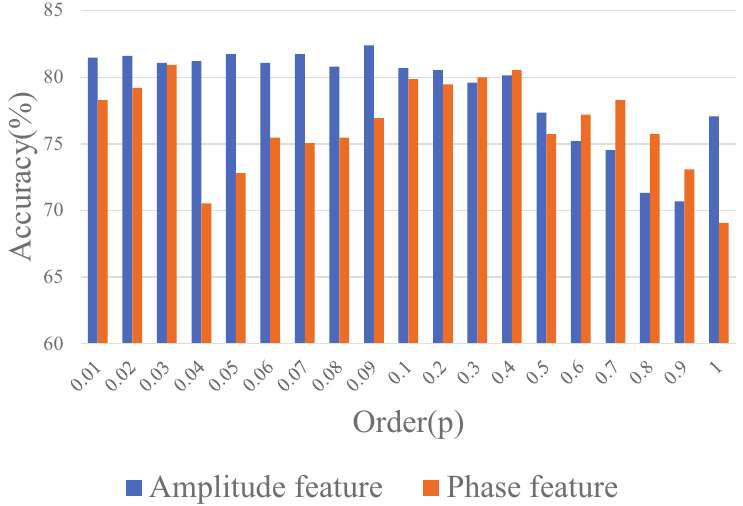
Figure 11. Classification results of Amplitude and Phase features under different orders using VAIS